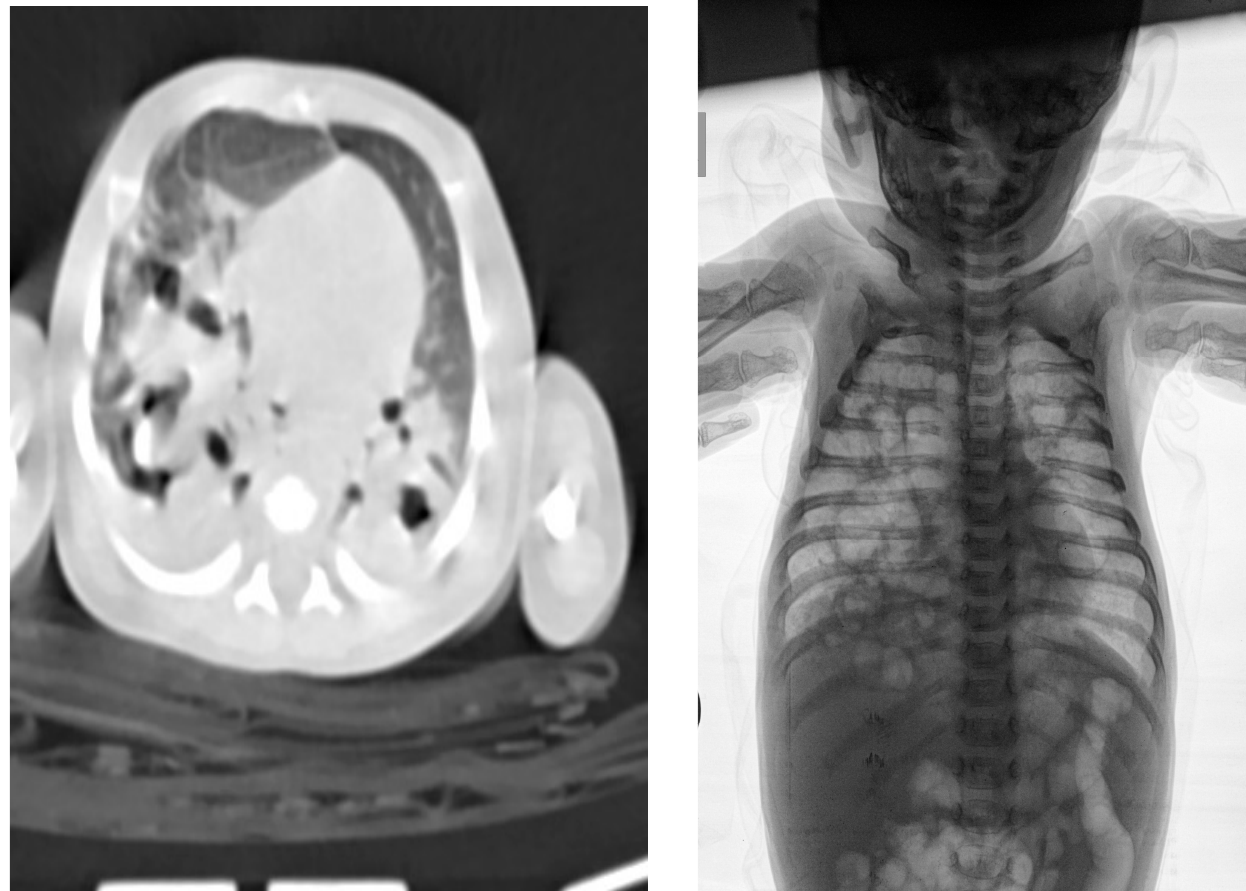
1.3 mm. Circular hyperechoic changes on both sides, around the tops of the lateral chambers. Right periventricular, hematoma with signs of resorption, 4 mm in diameter. Pronounced and diffuse hyperechogenicity in the parenchyma. Circulation in the a. pericalosa shows orderly velocities with low resistance RI = 0.53.